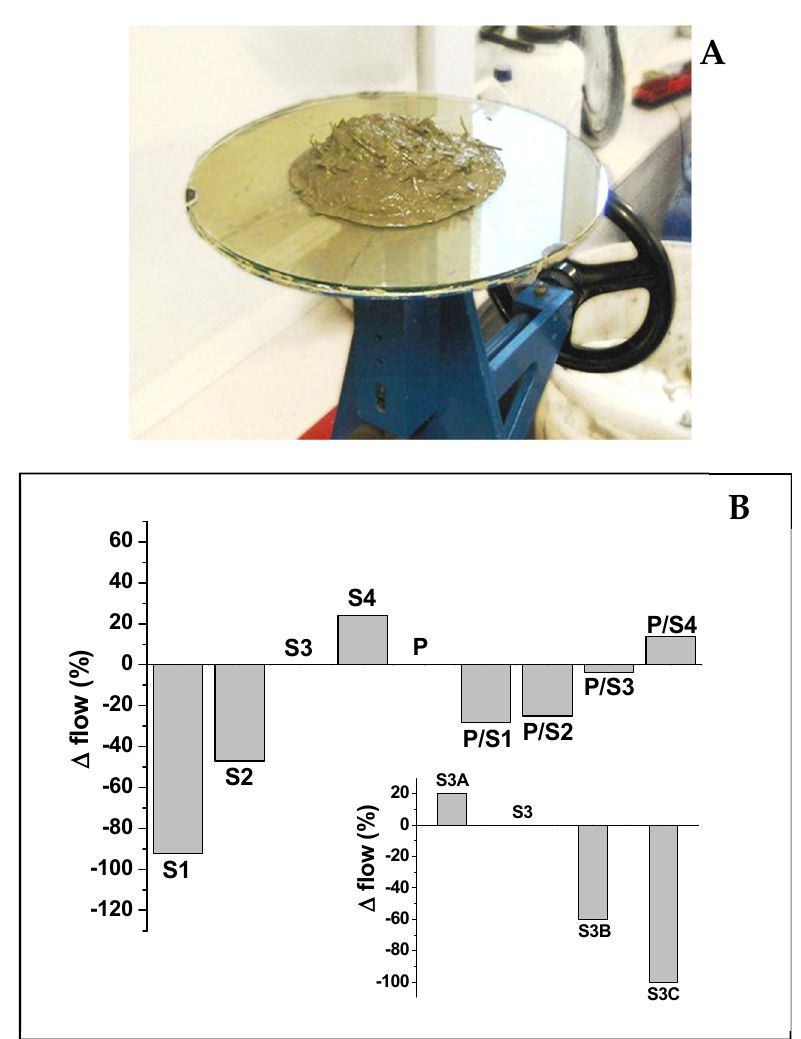
Figure 3. ( A ) Flow-test apparatus. ( B ) Flow-test results of the S, P and P/S samples with respect to the normalised mortar (Control).